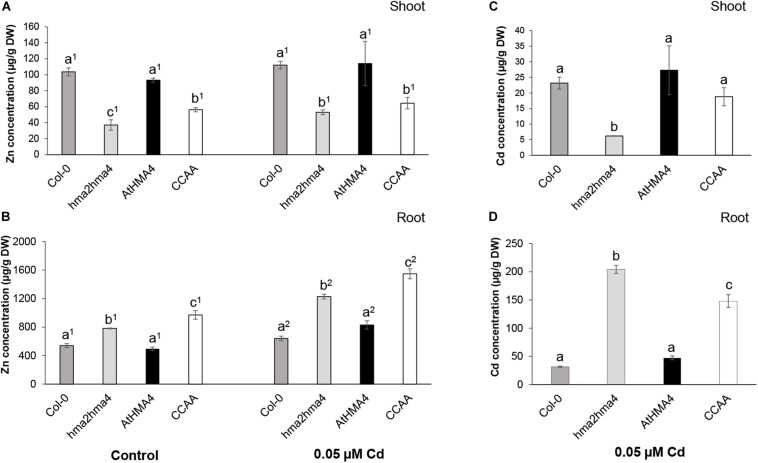
Zinc and cadmium accumulation in shoot (A,C) and root (B,D) tissues of wild-type (Col-0), hma2hma4 mutant, and hma2hma4-expressing AtHMA4 or AtHMA4CCAA plants upon hydroponic growth in control conditions (1 μM Zn, no Cd) or exposed for 3 weeks to 0.05 μM Cd. Values (in μg g–1 DW) are means ± SD of three biological replicates each consisting of pools of three plants from two independent lines per genotype. Statistically significant differences (P < 0.05) between genotypes within treatments (one-way ANOVA followed by Tukey’s multiple comparison test) or between treatments within genotypes (t-test for independent means) are indicated by different letters or different superscript numbers, respectively. DW, dry weight; CCAA, di-Cys → di-Ala motifs.